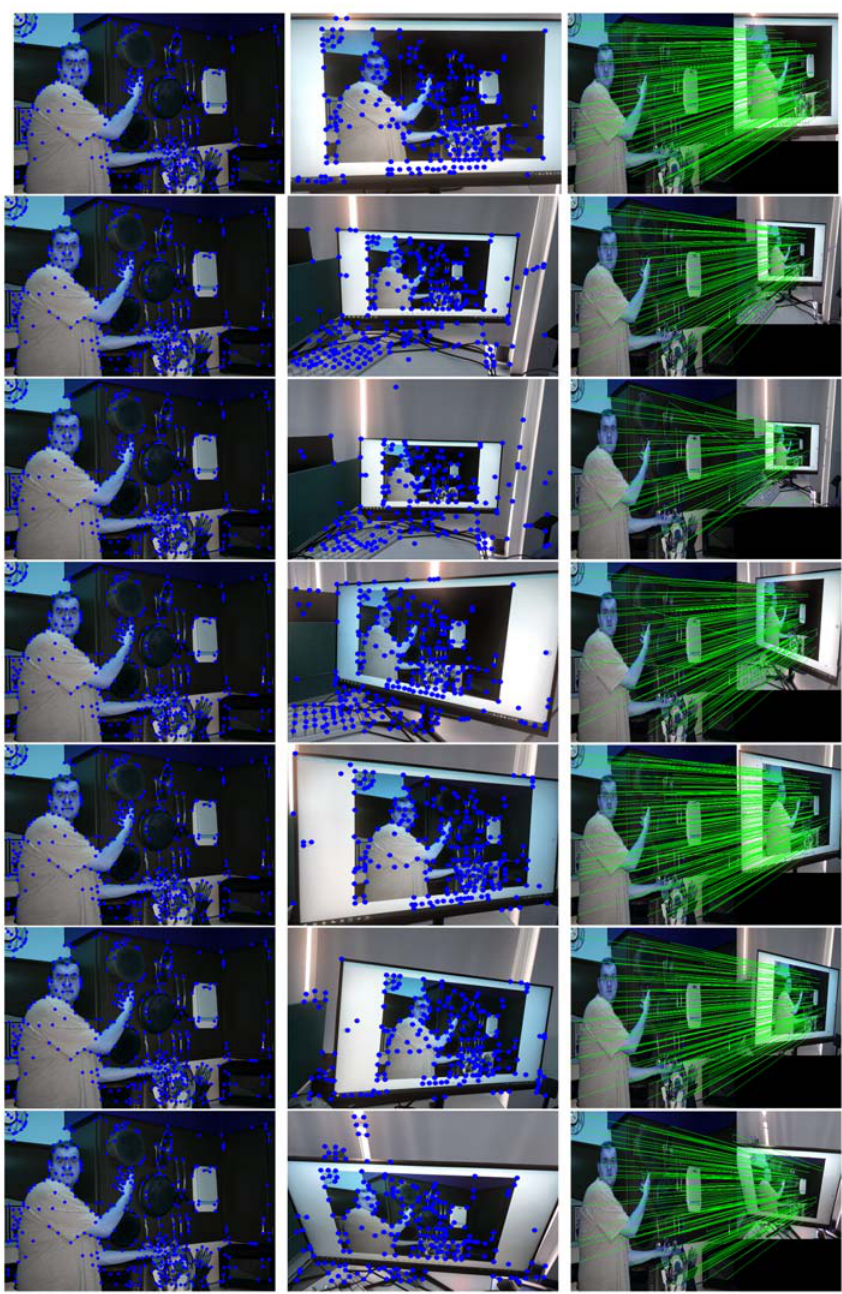
Figure 18. Keypoints correspondences detected with different